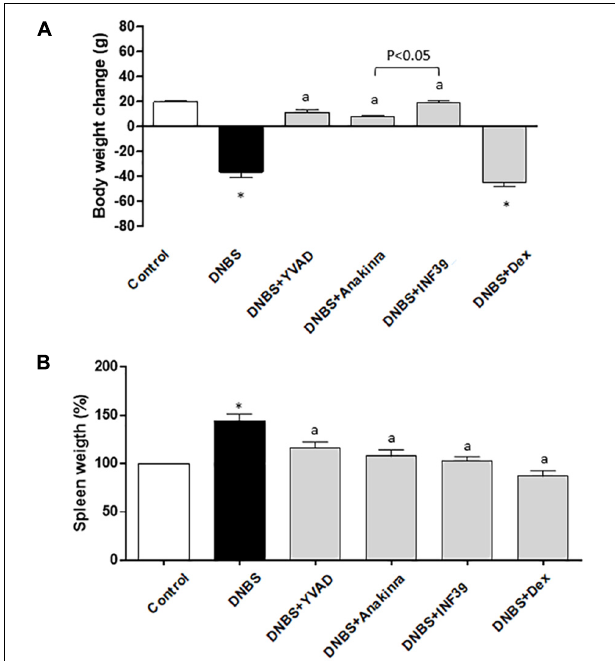
FIGURE 1 | Effects of Ac-YVAD-cmk (YVAD, 3 mg/Kg), anakinra (100 mg/Kg), INF39 (25 mg/kg) or DEX (1 mg/kg) on body weight gain/loss (A) and spleen weight changes (B) , at day 6 after induction of colitis with DNBS. Each column represents the mean ± S.E.M. ( n = 10). ∗ P < 0.05, significant difference vs. control group; a P < 0.05, significant difference vs. DNBS group.